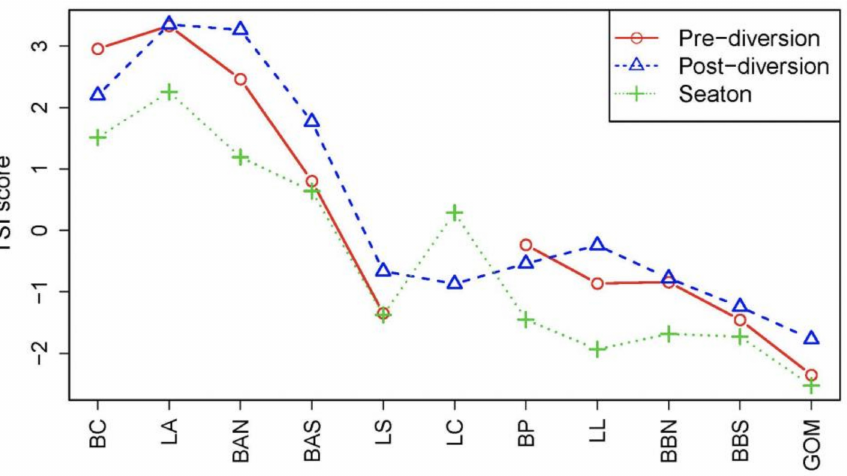
Figure 10. Trophic state index scores for station groupings for the Seaton (1977–1978), pre-diversion (1994–2002 June) and post-diversion (July 2002–2016) transects (from [18]). Locations on the horizontal axis are defined in Figure